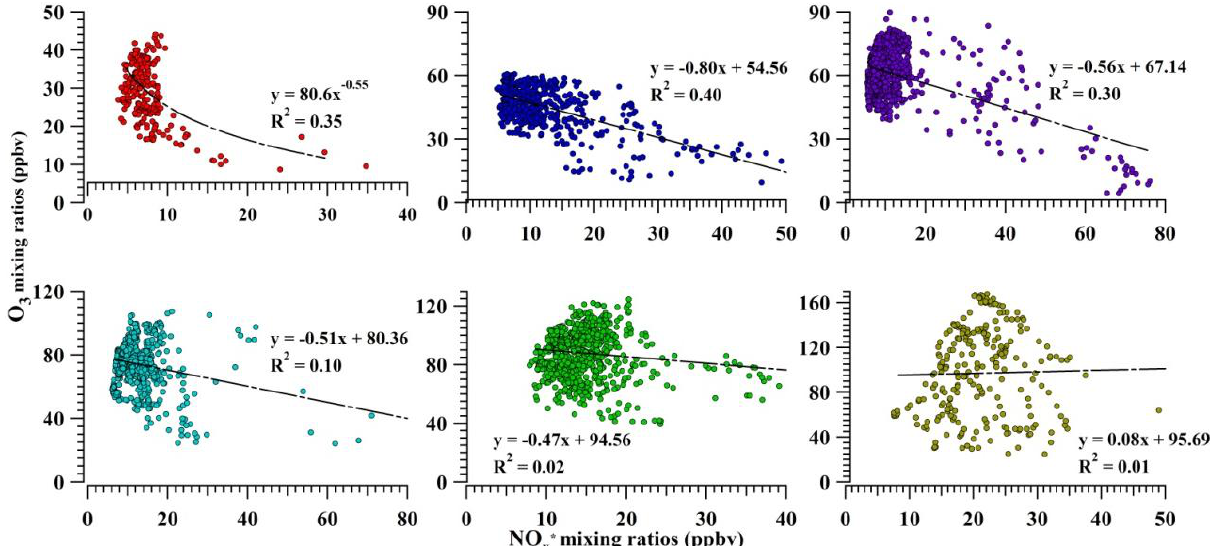
Fig. 10. Scatter plots of O 3 (ppbv) vs. NO ∗ x (ppbv) for the days with the hourly peak O 3 of (a) 20 ≤ O 3 ≤ 40; (b) 40 < O 3 ≤ 60; (c) 60 < O 3 ≤ 80; (d) 80 < O 3 ≤ 100; (e) 100 < O 3 ≤ 120; (f) O 3 > 120 at TMS during sampling period.